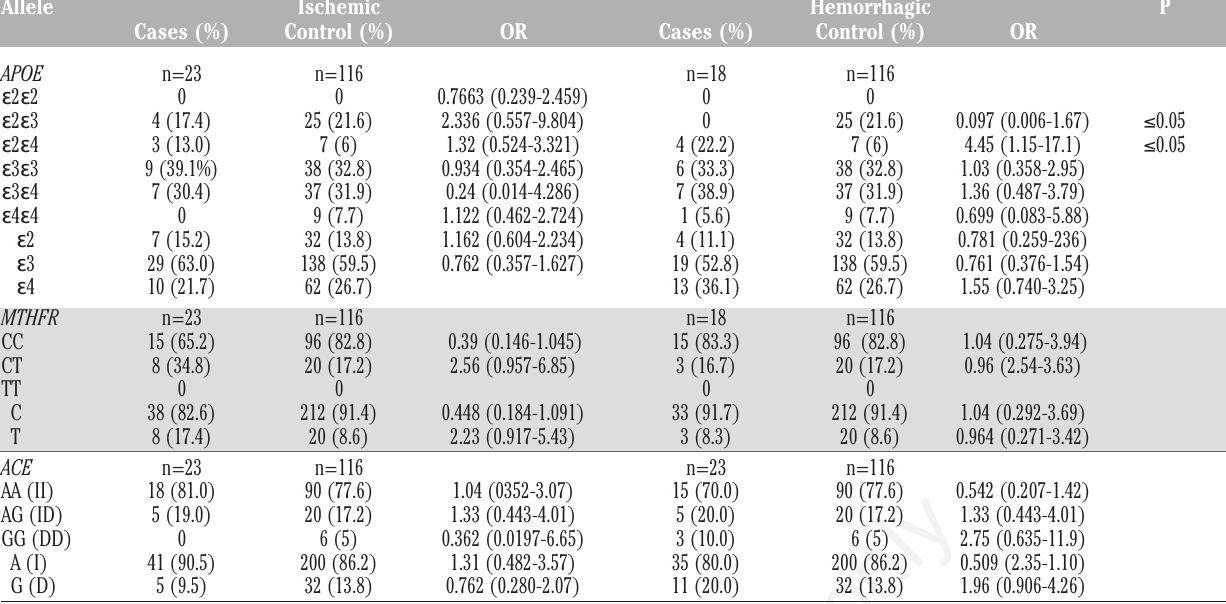
Table 2. The genotype and allele data of ischemic and hemorrhagic cases and controls.